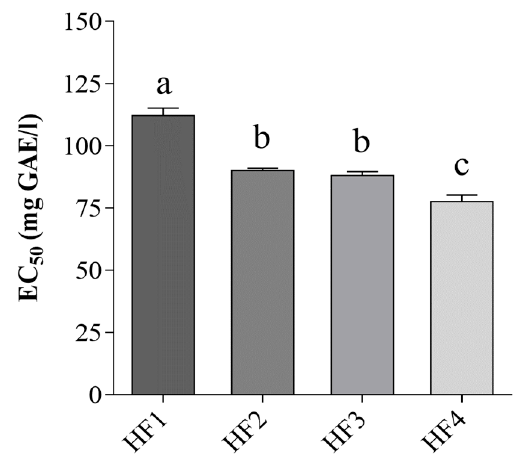
Figure 3. Antioxidant capacity of di ff erent CBS extract fractions from Honduras. Antioxidant capacity was analyzed by performing DPPH · radical scavenging assay. The highest antioxidant activity was recorded in HF4 analysis. The results are reported as EC 50 equivalent concentration and expressed as mg / L (mg equivalents of TPC / L of fraction). Data are reported as mean values ( n = 3) ± SD. One-way analysis of variance (ANOVA) with Duncan’s test was used as a multiple range test to highlight the significant di ff erences among all the treatments. ANOVA was considered significant for p < 0.001. Means with di ff erent lowercase letters within the same column are significantly di ff erent (Duncan’s test, p < 0.05): a di ff erent from HF2, HF3, HF4; b di ff erent from HF1, and HF4; c di ff erent from HF1, HF2, HF3.